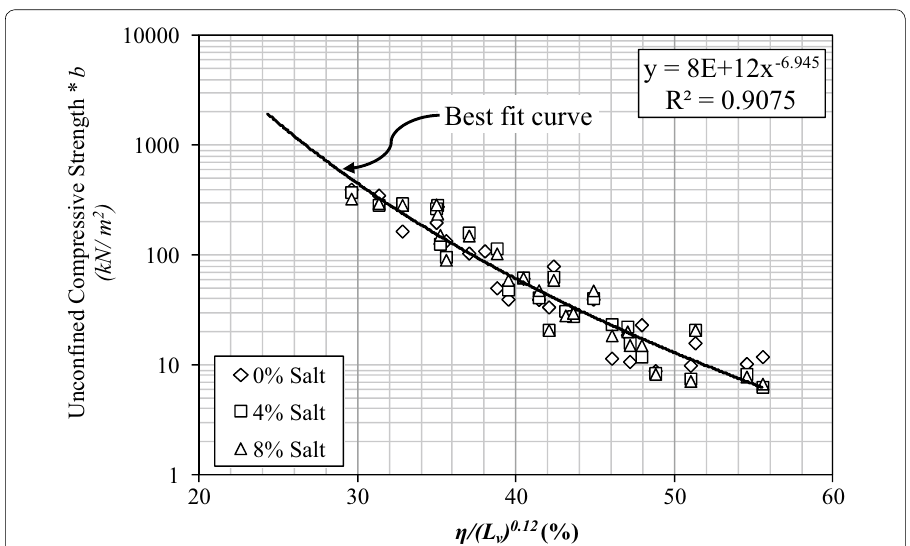
Fig. 14 Best fit normalized curve of unconfined compressive strength for different porosities, lime content and salt